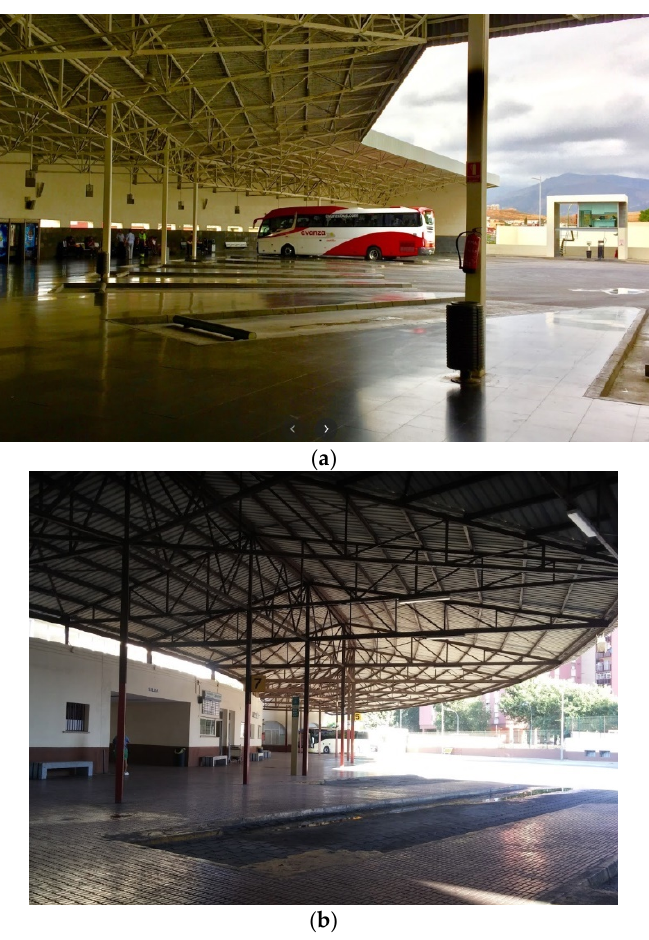
Figure 7. Bus stations ( a ) San Bernardo and ( b ) La Linea.